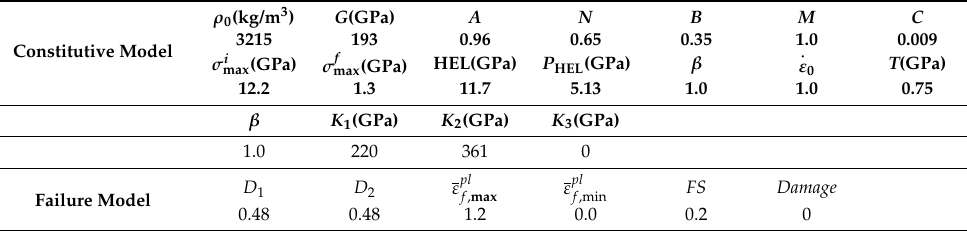
Table 3. The model constants of SiC